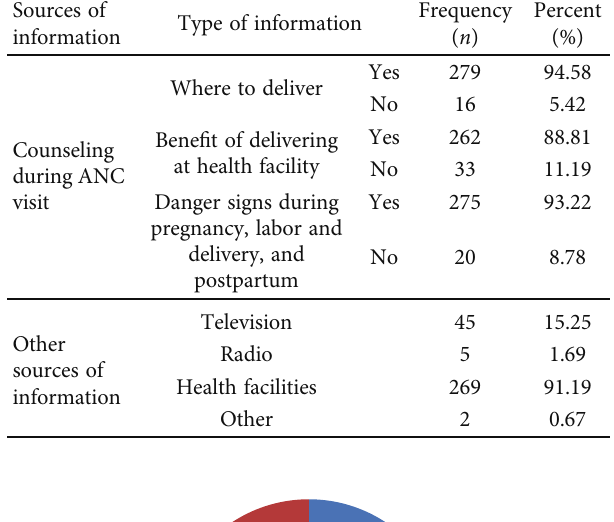
Table 3: Obstetric history of pregnant women in DebreTabor town, Northwest Ethiopia, 2021.